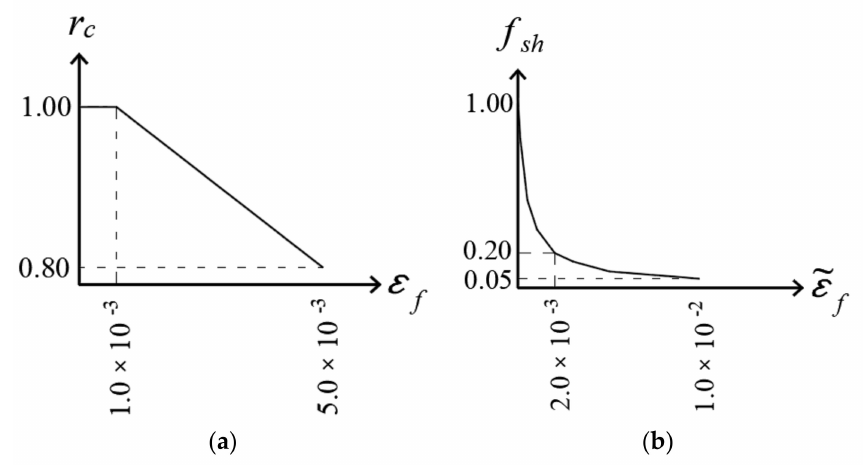
Figure 3. Functions of concrete strength reduction factors: ( a ) Compressive strength; ( b ) shear strength.